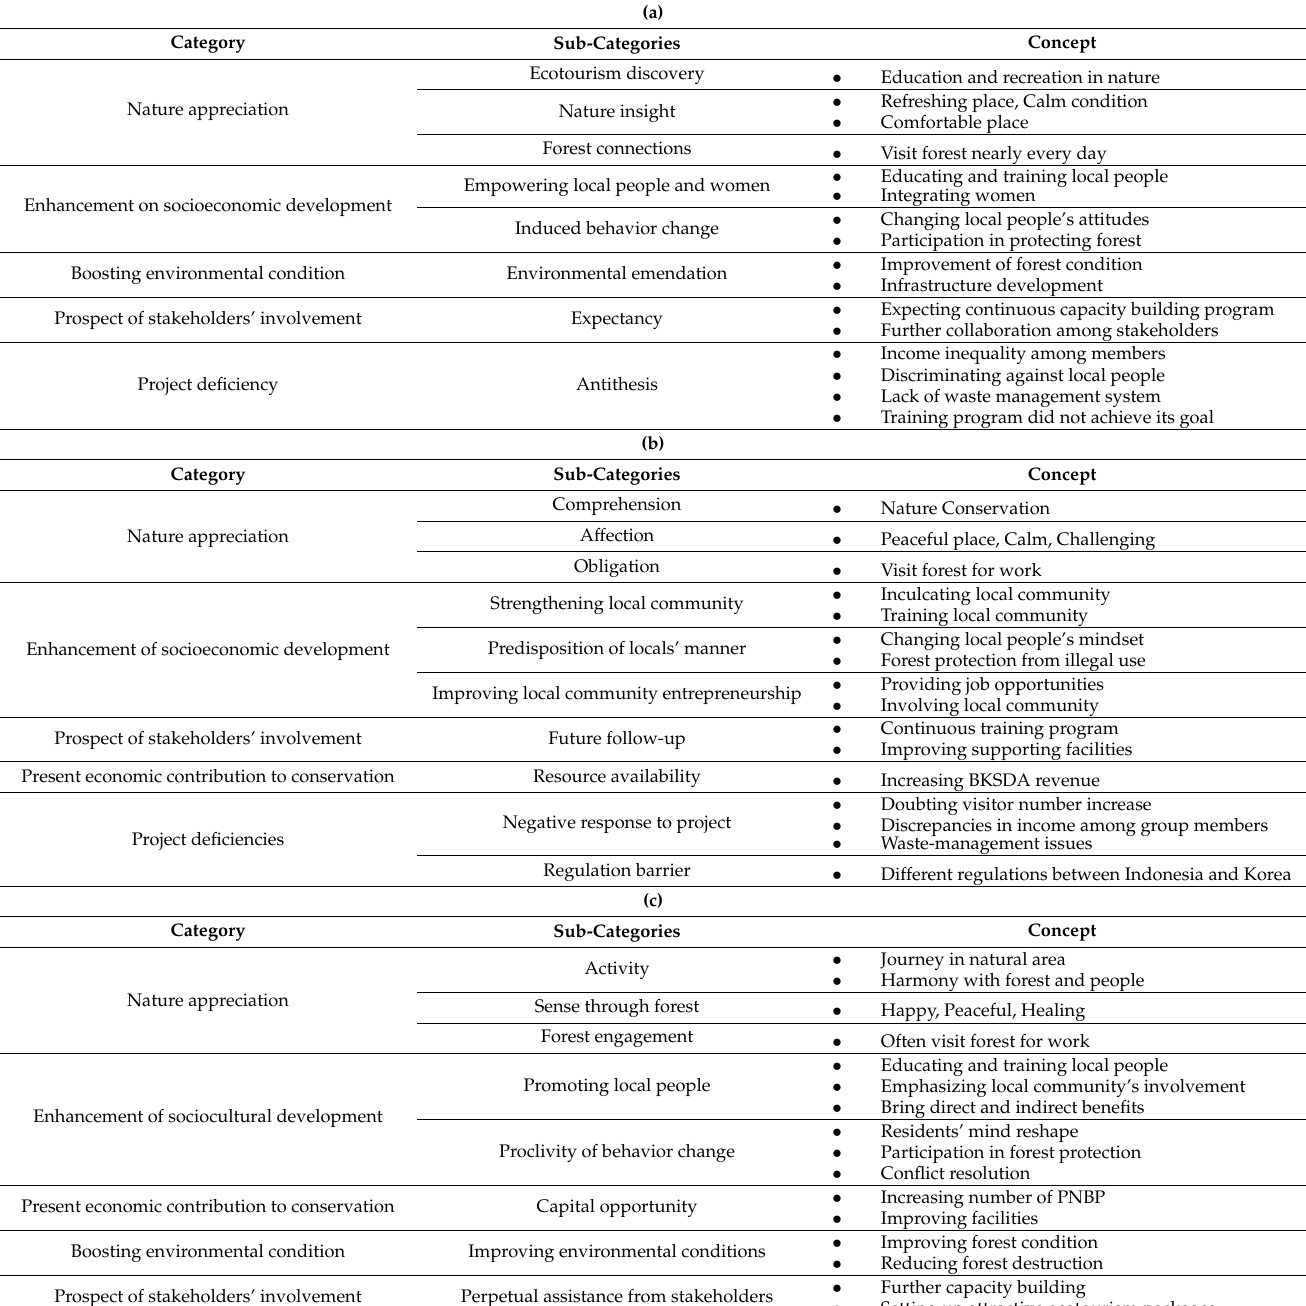
Table 4. (a) Summary of Coding Processes of Local community. (b) Summary of Coding Processes of Project executors. (c) Summary of Coding Processes of Government